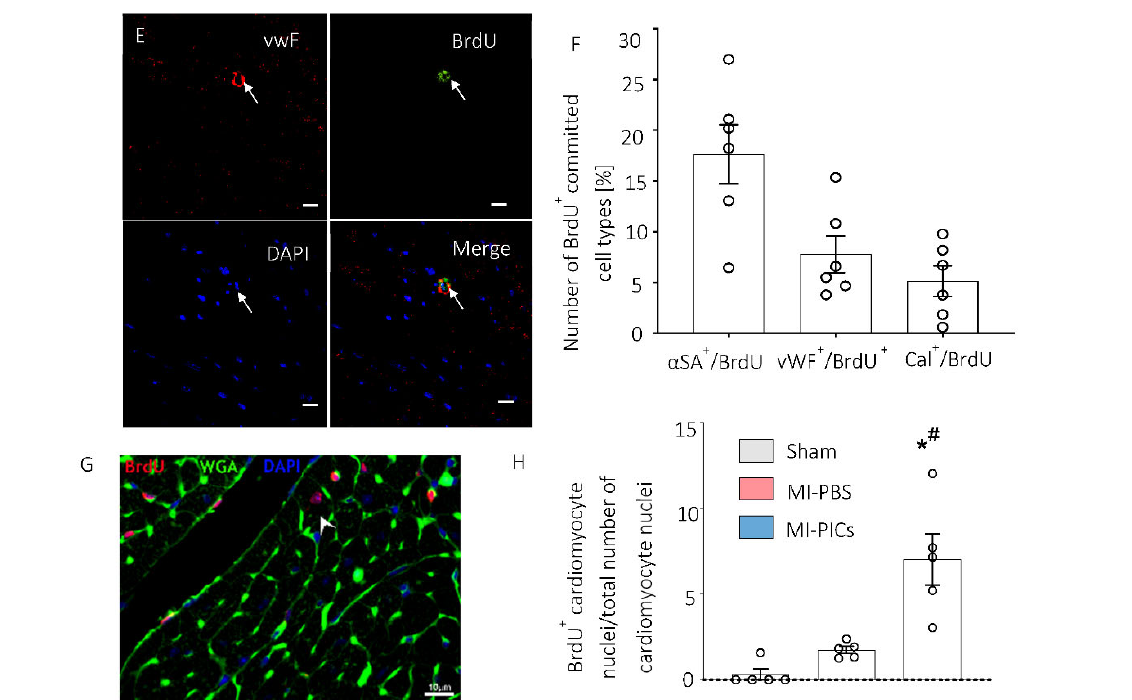
Figure 4. PICs transplantation increases proliferation and number of BrdU + cardiomyocytes . ( A ) Representative confocal micrographs in the RR of the LV of BrdU (Red) positive cells. DAPI stain nuclei blue. Scale bar = 10 µ M. Arrows indicate positive staining colocalisation. ( B ) Quantification of the number of proliferating BrdU-positive cells in the RR in Sham = 8, MI-PBS = 7 and MI-PICs = 6 groups. Data are Mean ± SEM of the total number of BrdU + cells over the total number of cells (DAPI), * p < 0.05 vs. sham, # p < 0.05 vs. MI-PBS. ( C – E ) Representative confocal micrographs in the RR of the LV of BrdU (Green) positive, α -sarcomeric actin-expressing (( C ), Red), calponin-expressing (( D ), Red) or vWF-expressing (( E ), Red) cells. DAPI stain nuclei blue. Scale bar = 10 µ M; arrows indicate positive staining colocalisation. ( F ) Quantification of the number of BrdU+ trilineage cardiac expressing cells. Data are Mean ± SEM. ( G ) Representative image of BrdU + cardiomyocyte (WGA) in MI-PICs. DAPI stain nuclei blue. Arrows indicate cells that show colocalisation. Sham = 5, MI-PICS = 5 and MI-PBS = 5. Scale bar = 10 µ M. ( H ) Percent number of BrdU + cardiomyocytes in the RR. Data are Mean ± SEM. * p < 0.05 vs. sham, # p < 0.05 vs.